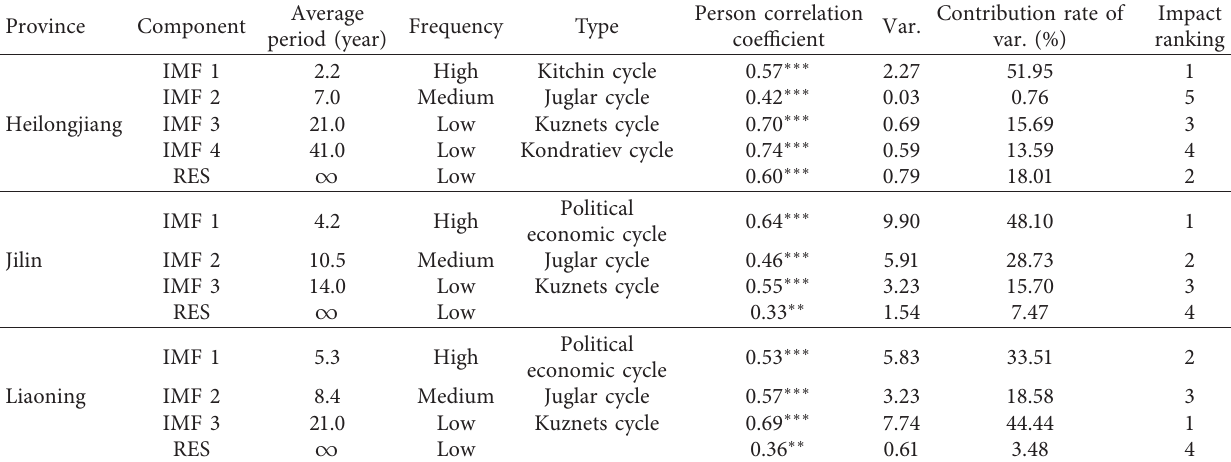
Table 1: Statistical features of the business cycle components and trend terms.